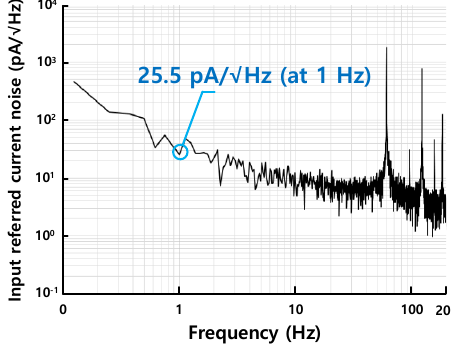
Figure 12. ( a ) Output in the current-sensing mode. ( b ) Transfer function of the current-sensing mode.